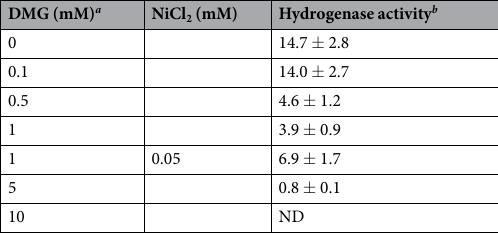
Table 1. Effect of DMG chelation on hydrogenase activity in S . Typhimurium 14028. a DMG was added to a blood-based medium, and cells were grown for 6 h under H 2 -enriched microaerobic conditions before being harvested. b nanomoles H 2 oxidized per min per 10 9 cells. Values shown are the mean ± standard deviation for 6 independent replicates. Results beginning with 0.5 mM of DMG are significantly less than without DMG ( P < 0.01%, Student’s t